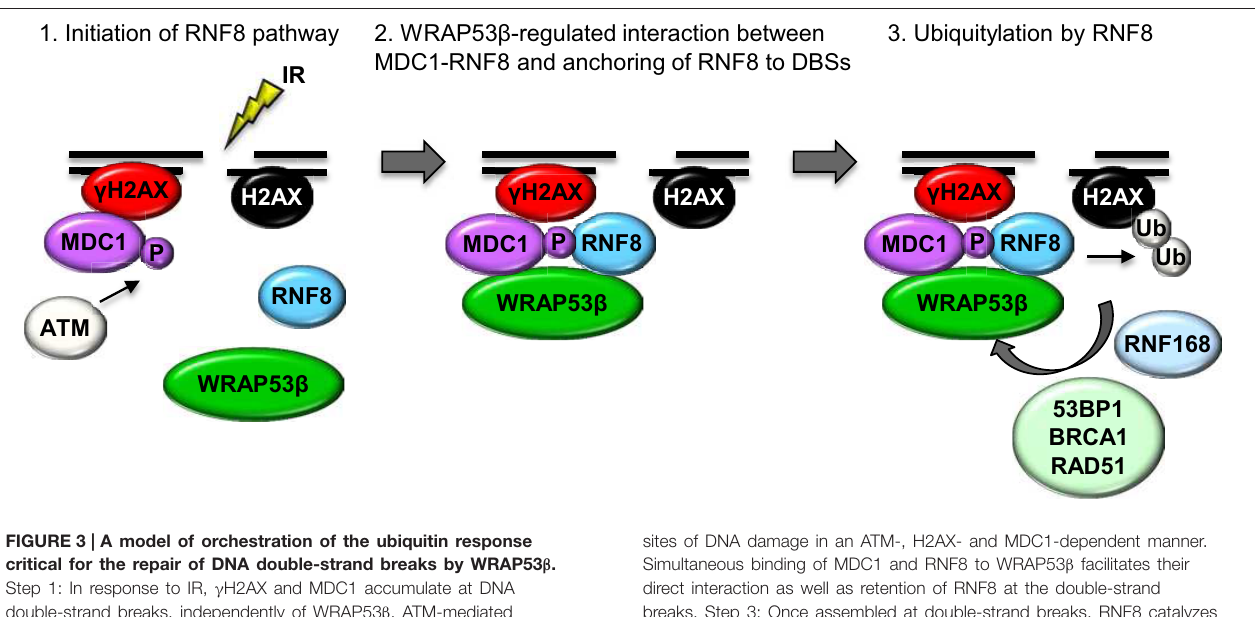
FIGURE 3 | A model of orchestration of the ubiquitin response critical for the repair of DNA double-strand breaks by WRAP53 β . Step 1: In response to IR, γ H2AX and MDC1 accumulate at DNA double-strand breaks, independently of WRAP53 β . ATM-mediated phosphorylation of MDC1 allows it to bind RNF8, which however, is not yet localized to the damaged site. Step 2: WRAP53 β is recruited to the